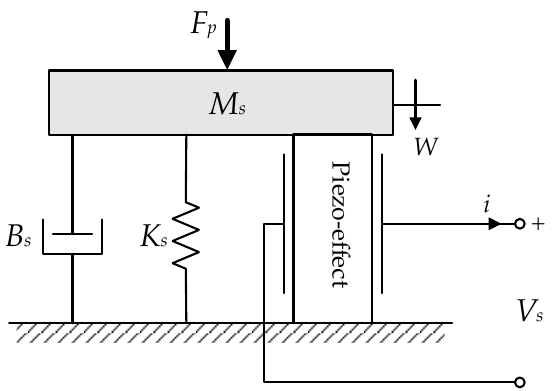
Figure 2. Equivalent mechanical model to describe relationship between external force and deformed displacement [25,27].